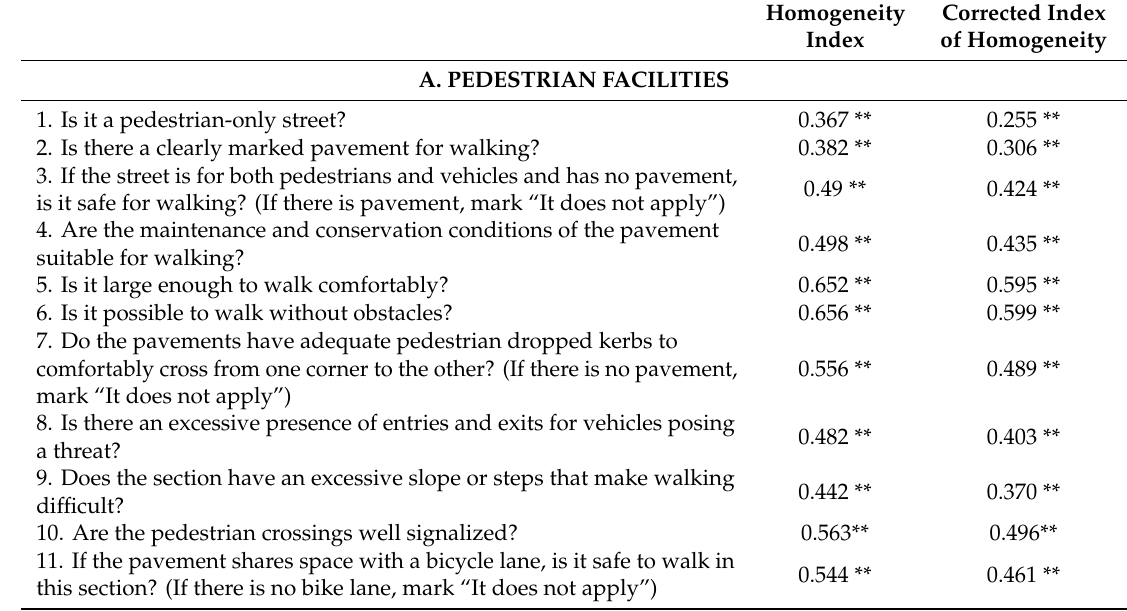
Table 2. Homogeneity index and corrected index of homogeneity for the items of the